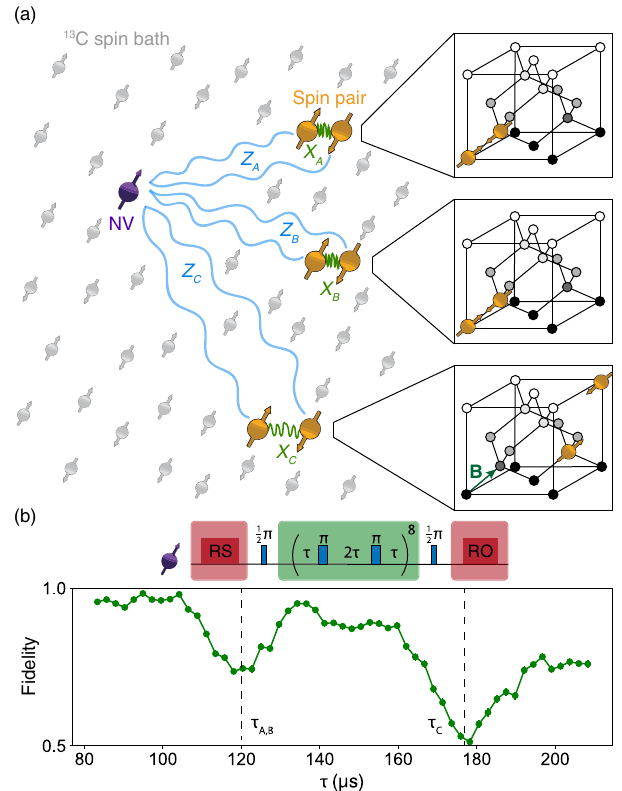
FIG. 1. System and basic spectroscopy. (a) We study three 13 C spin pairs ( A , B , and C ) in a diamond. The pairs are detected and controlled using a nearby NV center. The insets show the spatial configuration of the pairs. Pairs A and B are nearest-neighbor pairs oriented along the external magnetic field B z . For pair C , we show one of the three possible orientations (Appendix H). The main source of decoherence is the surrounding bath of 13 C spins (1.1% abundance). (b) Sensing the pair pseudospins [11,13,14]. The NV electron spin is prepared in a superposition, and a periodic sequence of π pulses is applied. If the interpulse delay is resonant with the dynamics of a pair, a loss of electron coherence is observed. We set τ ¼ m 2 π = ω L with m an integer and ω L the 13 C Larmor frequency to avoid interactions with individual 13 C spins [11,14]. The vertical lines mark the values for τ used in this work and τ 177 . 026 μ s). The NV spin is prepared (RS) and read out C ¼ (RO) optically (Appendix A). The error bars represent one standard